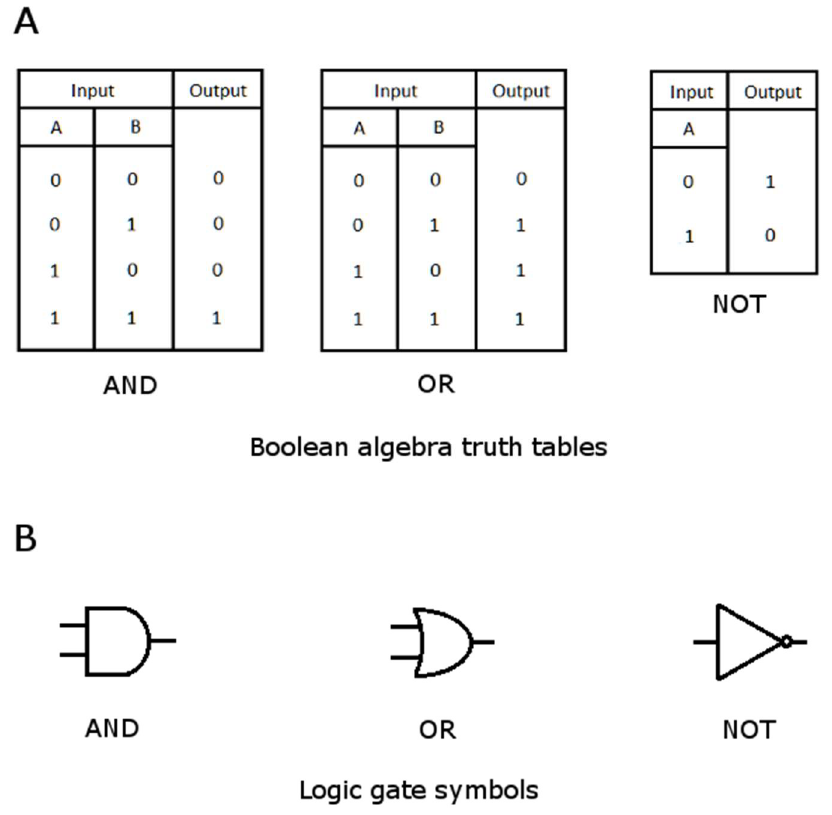
Figure 1. ( A ). Truth table for the basic Boolean operations AND, OR, and NOT. ( B ). The logic gate symbols represent the operations in ( A ).